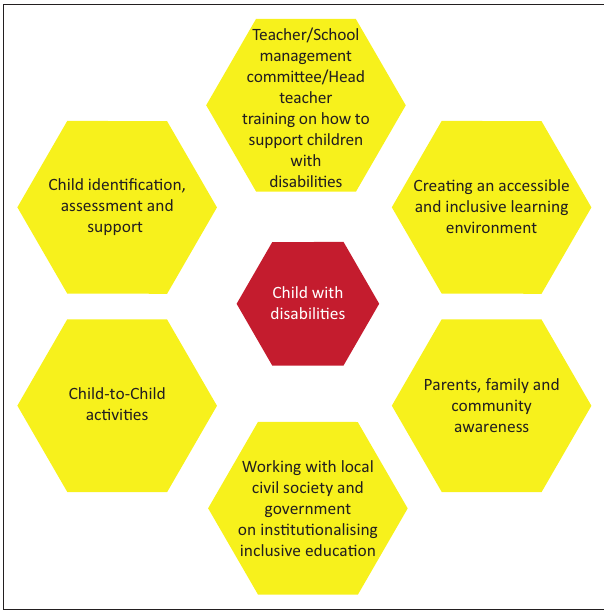
FIGURE 1: The (Organisation) inclusive education